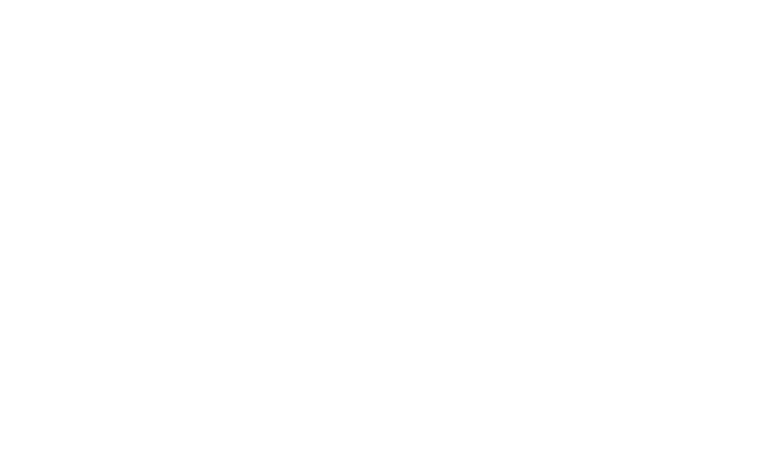
Figure 4. SDS ‐ PAGE analysis of KsLX3 ‐ SIase expressed in B. subtilis and purified using Ni ‐ NTA Figure 4. SDS-PAGE analysis of KsLX3-SIase expressed in B. subtilis and purified using Ni-NTA chromatography. M: protein marker, 1: purified SIase. chromatography. M: protein marker, 1: purified SIase.